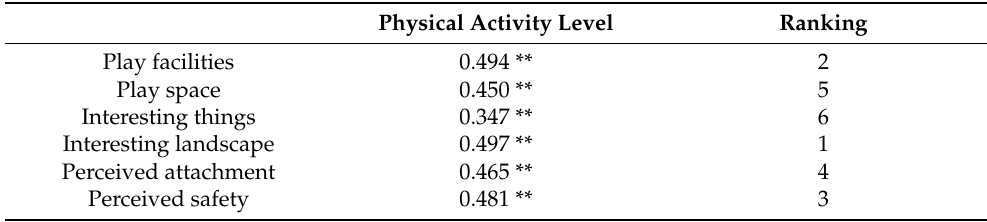
Table 5. Pearson correlation between environmental perception characteristics and physical activity level of